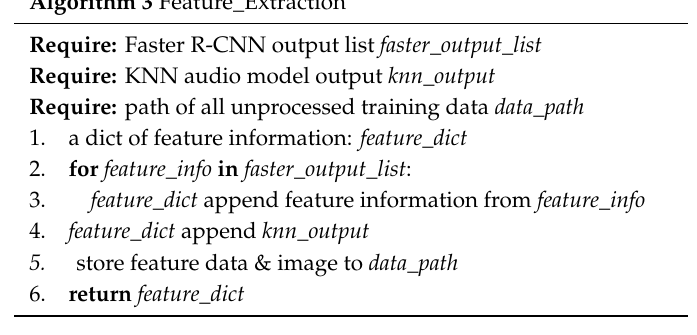
Algorithm 3 Feature_Extraction